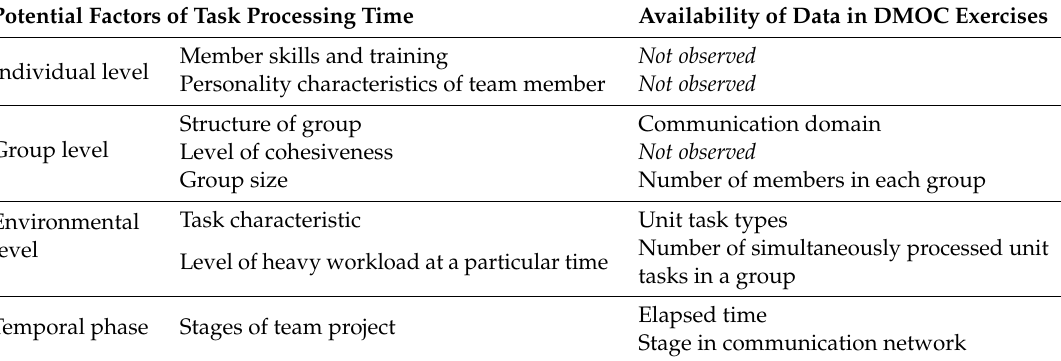
Table 1. Factors a ff ecting task processing